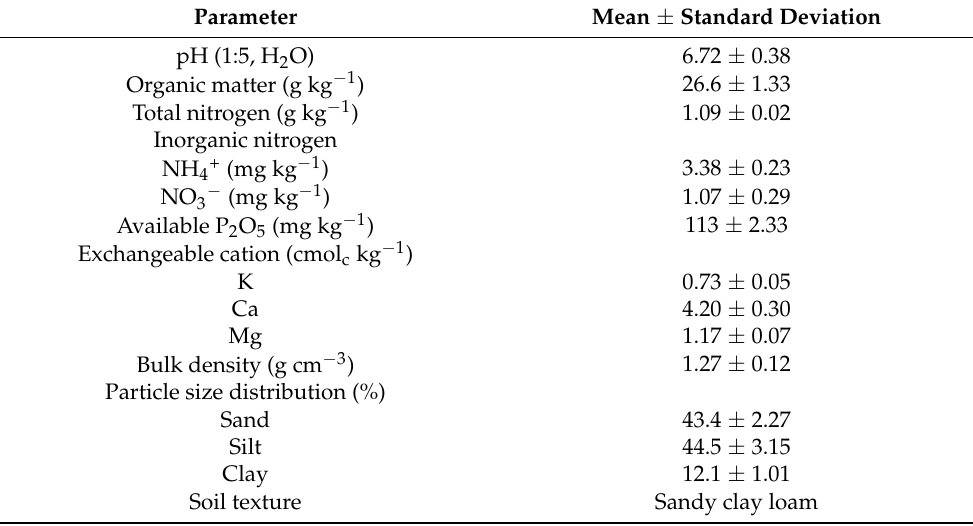
Table 1. Selected chemical and physical properties of the study soil ( n =